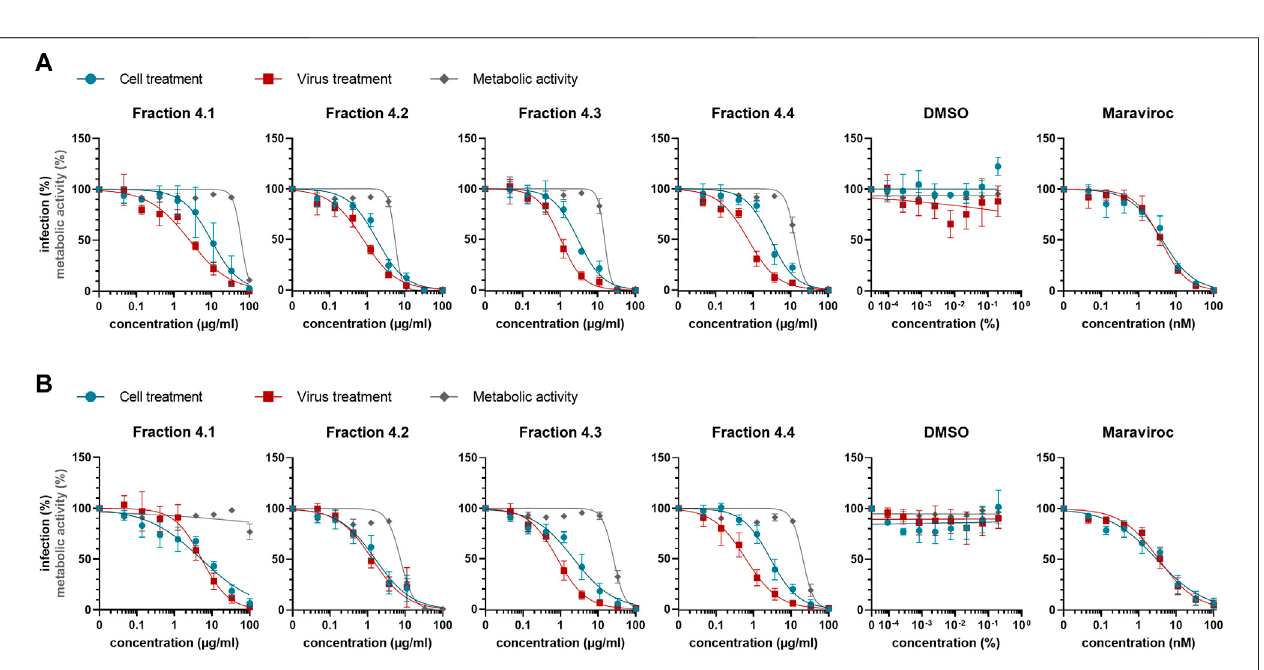
FIGURE 4 | Anti-HIV-1 activity of Viola tricolor peptide subfractions. Fraction 4 of extract #2 ( V. tricolor ) was further fractionated and fractions dissolved in 5% DMSO. (A) Fractions 4.1 – 4.4 and controls (solvent control DMSO and inhibitor maraviroc) were titrated and added onto seeded TZM-bl cells in serumfree